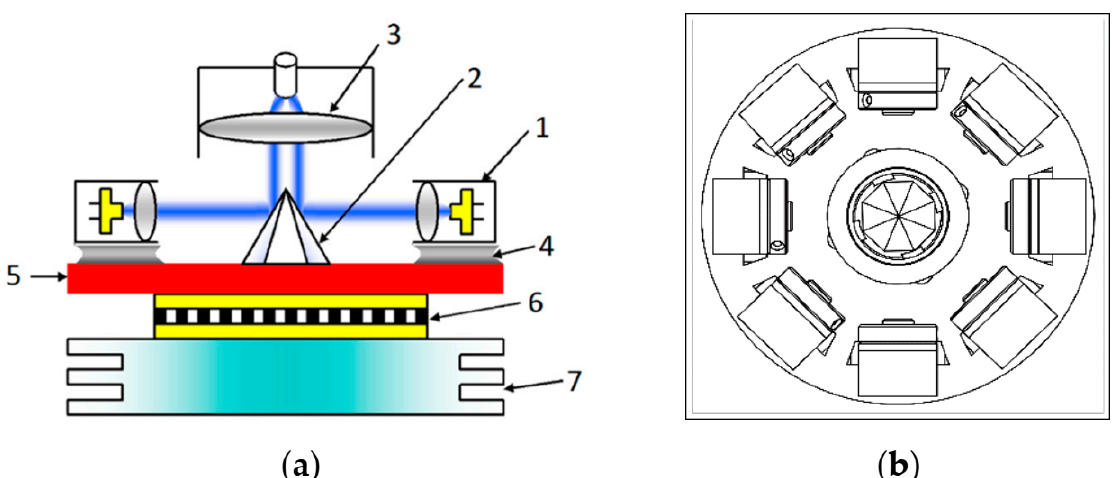
Figure 1. ( a ) Schematic drawing of our fiber-coupling method: laser modules (1) emit blue light (collimated by small lenses, grey), which is then reflected from triangular dielectric mirrors forming an octahedral pyramid (2) and focused into the fiber by the large lens (3). The laser modules are soldered (4) to the copper plate (5), cooled by the Peltier element (6), and placed on a heatsink (7) (reproduced from Review of Scientific Instruments 2014, 85, 036106, with the permission of AIP Publishing); ( b ) view from